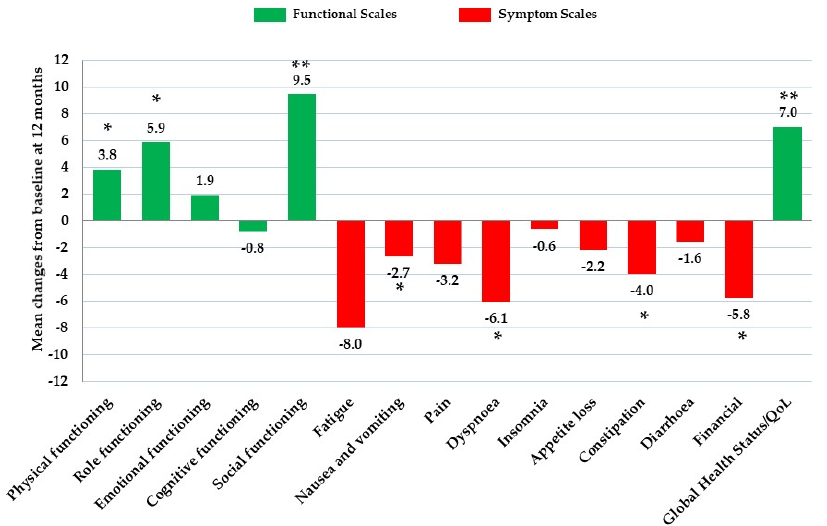
Figure 2. Mean changes of EORTC QLQ-C30 (European Organization for Research and Treatment of Cancer Quality of Life Questionnaire Core 30) scores from baseline at 12 months. (*) significance p < 0.05; (**) significance p < 0.001. In the breast cancer specific questionnaire EORTC QLQ ‐ BR23, at 12 months partici ‐ pants had significantly higher scores for body image ( p < 0.001) and future perspective ( p < 0.001) but lower scores for sexual functioning ( p = 0.025). Among symptoms, at 12